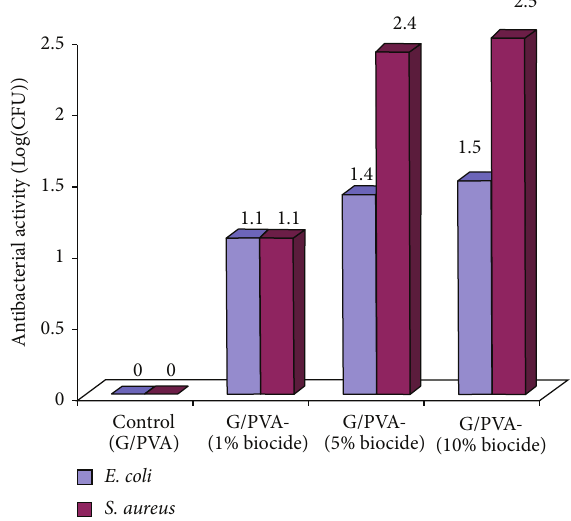
Figure 9: Comparison of the antimicrobial activity of the G/PVA- biocide antimicrobial nanocomposite films against E. coli and S. aureus